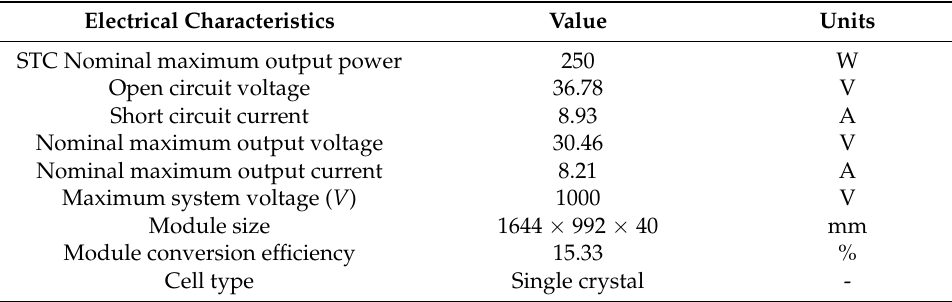
Table 4. Photovoltaic module electrical characteristic.